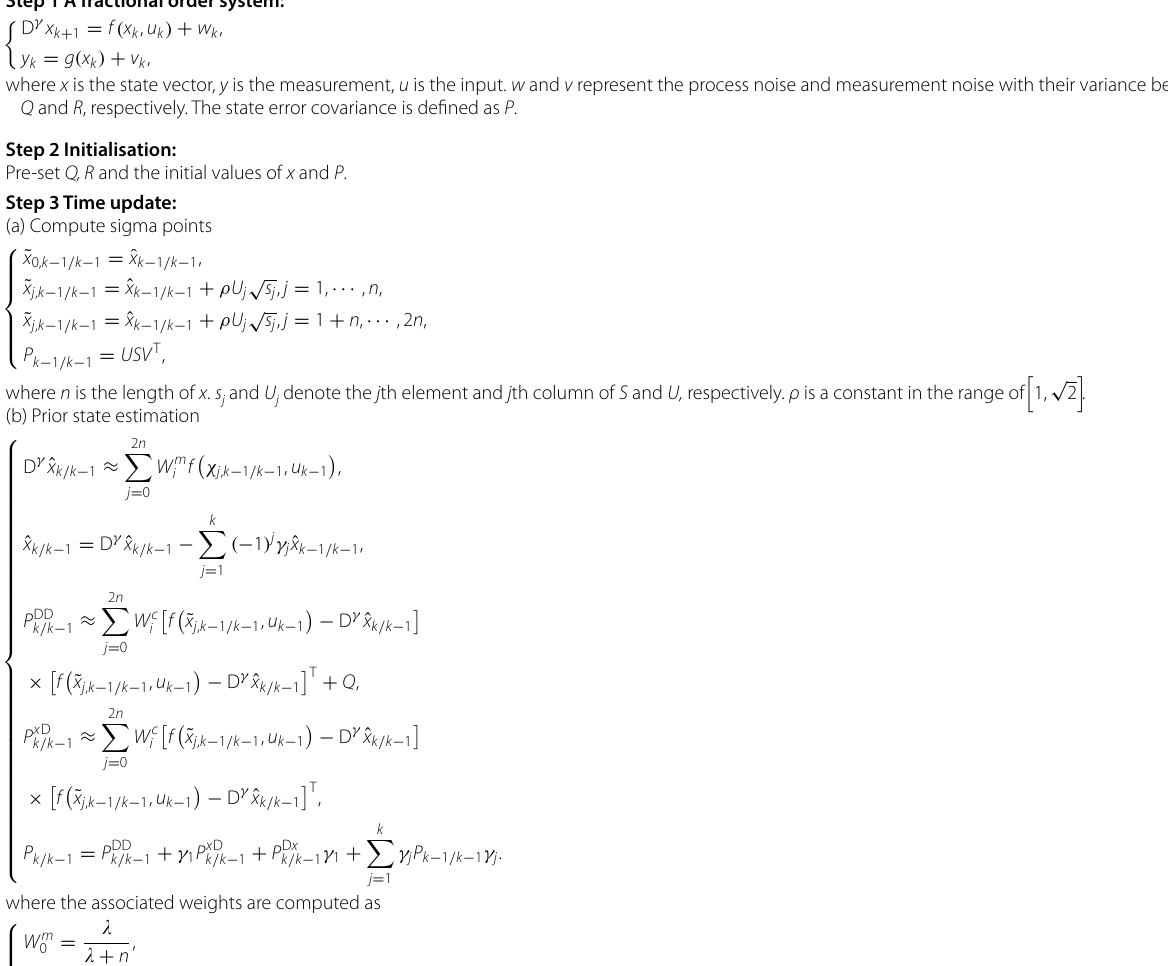
Table 5 Main procedures of the fractional order unscented Kalman filter Step 1 A fractional order